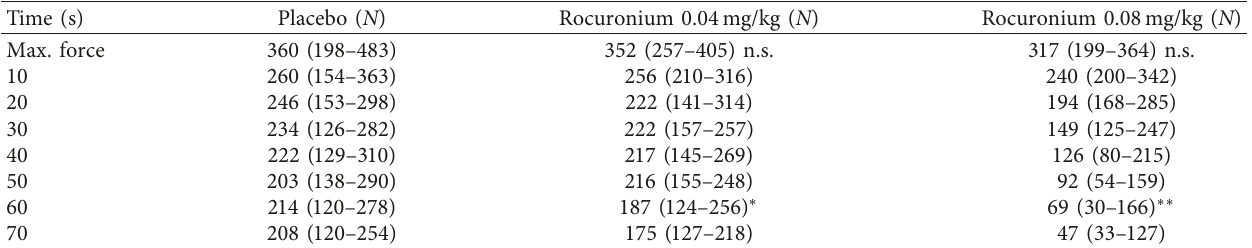
Table 1: Effect of placebo and different doses of rocuronium on sustained force (median (range)). Time (s)